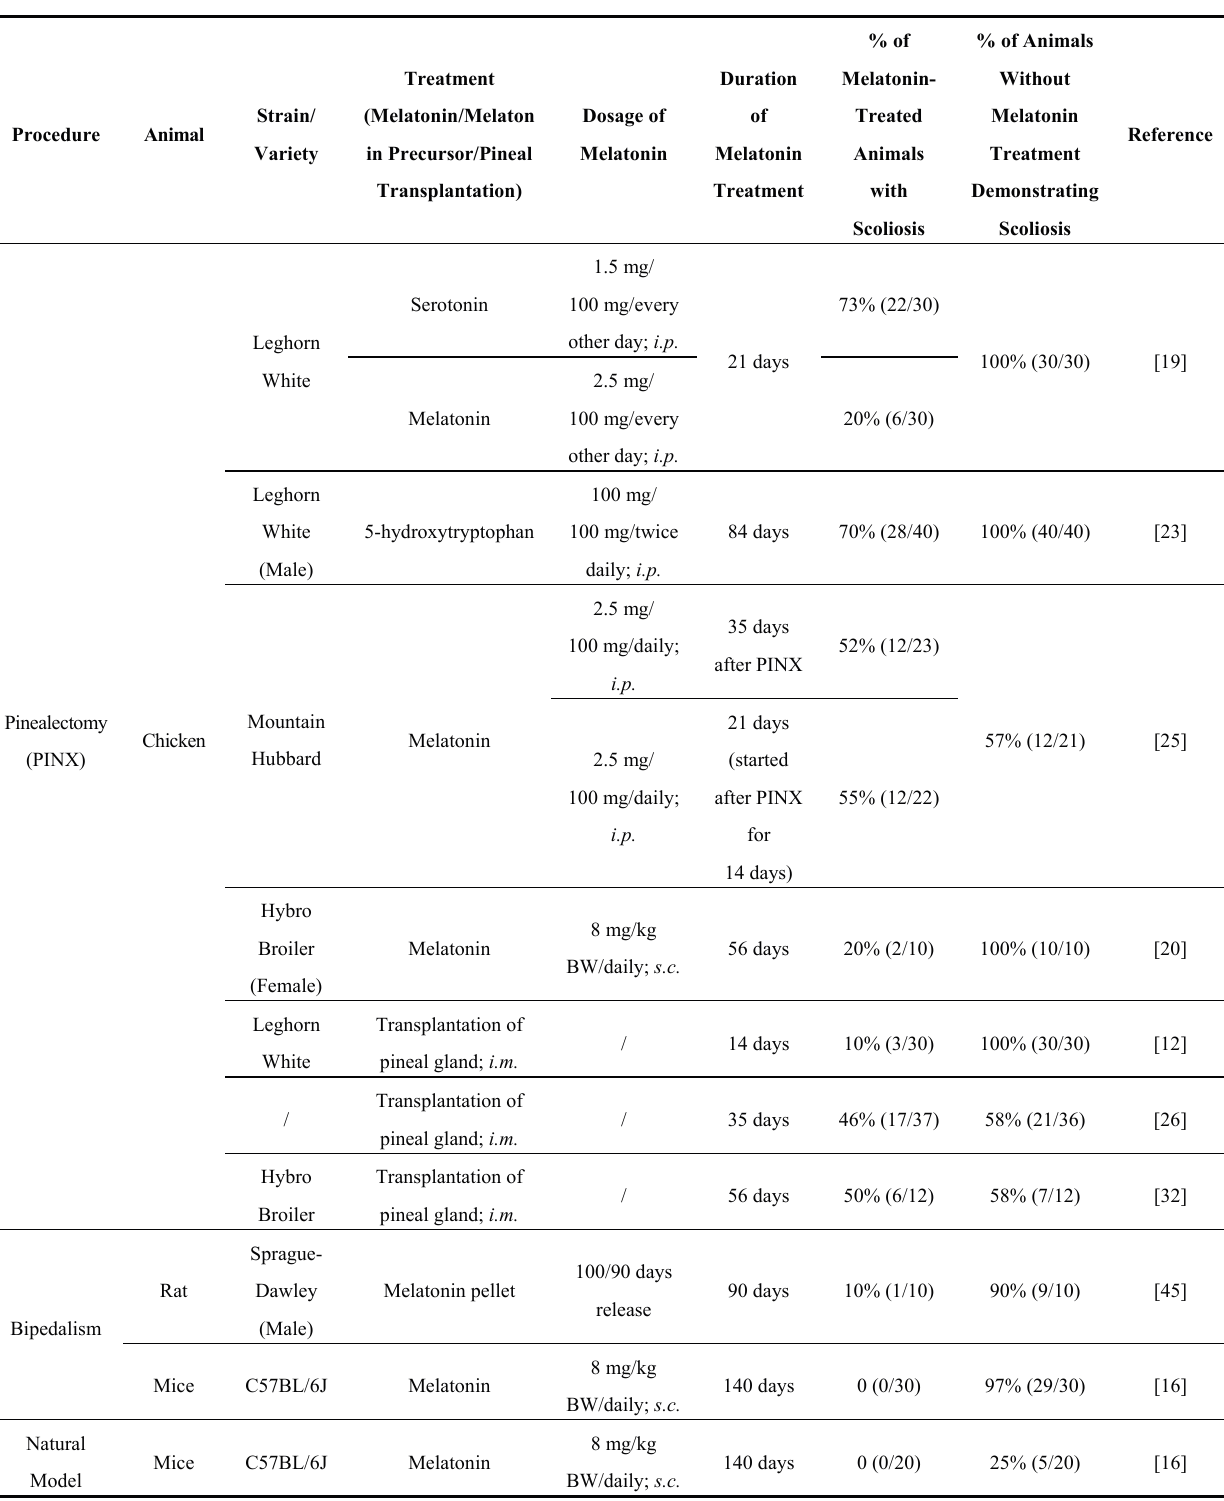
Table 2. Effect of exogenous melatonin on inhibiting scoliosis development in different